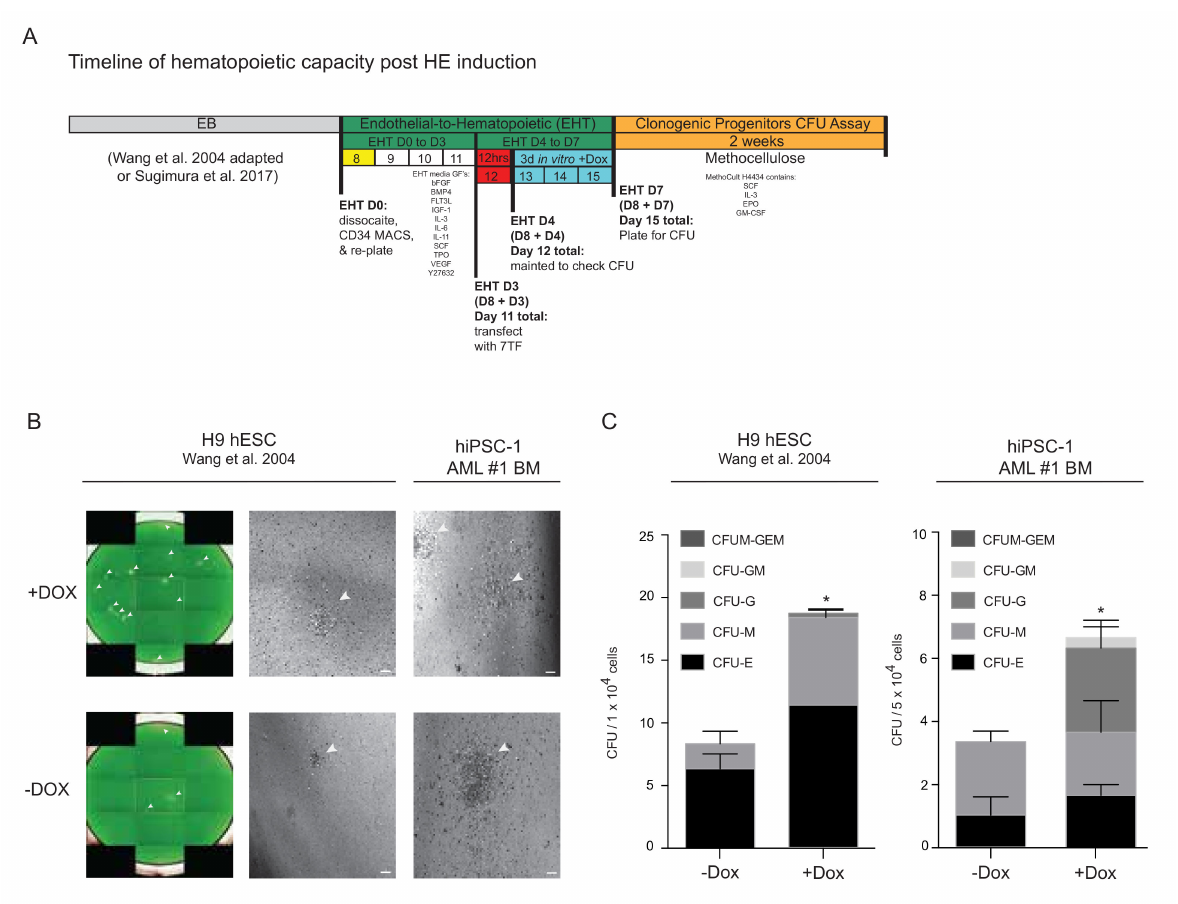
Figure 4. Progenitor capacity from hPSC-derived HE upon 7TF initiation. ( A ) Schematic depicting temporal forced expression of 7TF to assess clonogenic progenitor or “colony forming unit” (CFU) assay on HE derived from hPSCs (Sugimura et al. [32] and Wang et al. [38]). ( B ) Representative whole- well CFU images of hPSC lines stained by calcein-green (475 ex; 525 em) fluorescence on day 14 of cultures. Images were acquired at 2 × using Operetta High Content Screening (Perkin Elmer) by means of calcein-green am staining. Whole-well images were stitched in Columbus Image Data Storage and Analysis System version 2.9.0 (Perkin Elmer). Scale bar 2 µ m. White arrow heads highlight colonies formed (Wang et al. [38]). ( C ) Total number of hematopoietic colony forming units (CFUs) and number of colony subtypes CFU-Erythroid, CFU-Granulocyte, CFU-Monocyte/macrophage, and CFU-GM and CFU-GEMM (Wang et al. [38]). Unpaired Student t -test was performed for statistical analysis * = p < 0.05. All data shown are mean ± SEM (N = 3–4)